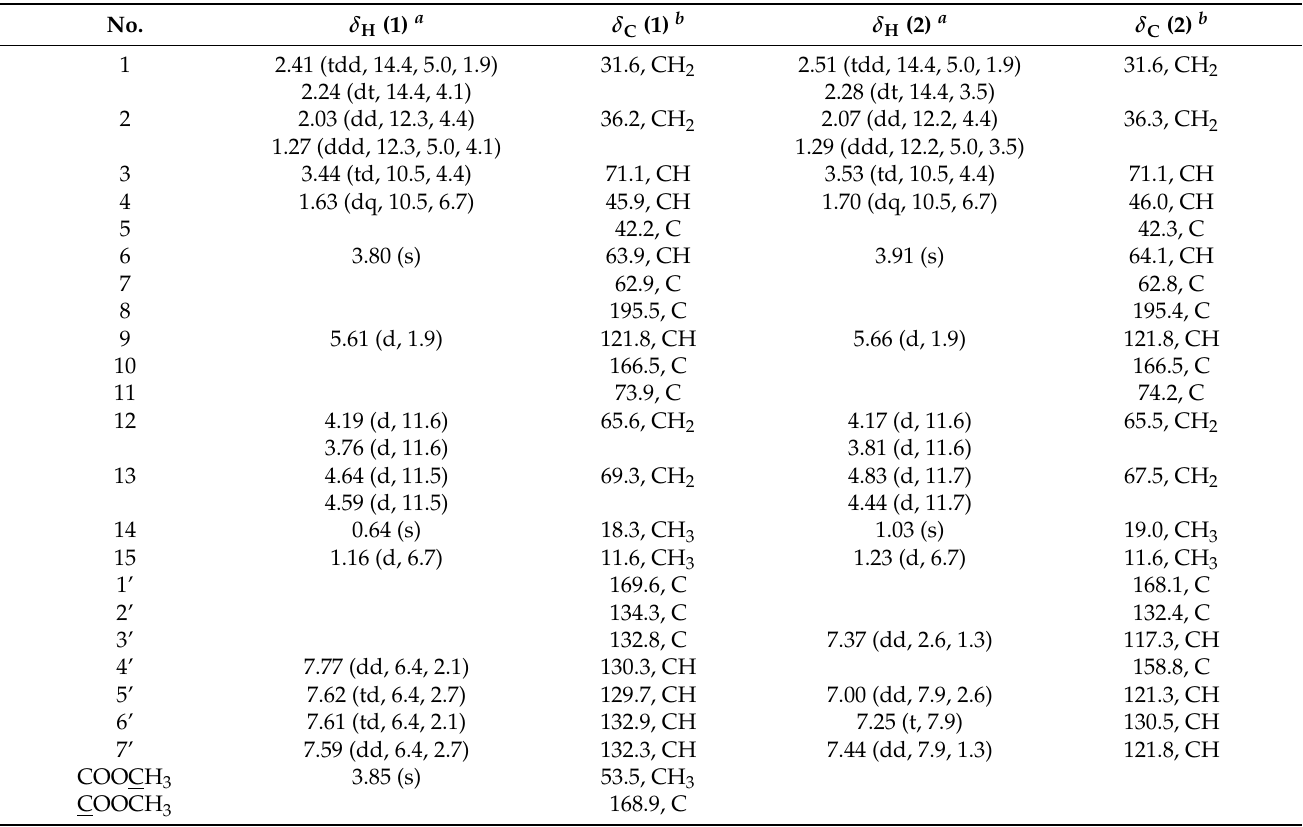
Table 1; HRESIMS (positive) m/z 345.13064 [M + Na] + (calcd for C 17 H 22 O 6 Na + , 345.13086). Table 1. 1 H and 13 C NMR Spectroscopic Data for 1 and 2 in Methanol- d 4 ( δ in ppm, J in